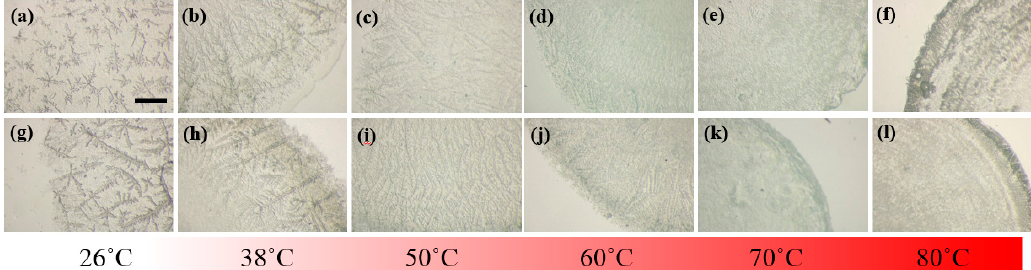
Figure 6. Stereoscopic images of the edges of ( a – f ) pure and ( g – l ) CsWO 3 NP-doped LAFs treated at various temperature. The scale bar shown in ( a ) is 1 mm, applicable to all images in this figure.